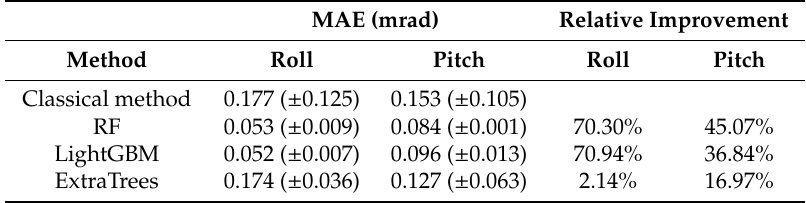
Table 8. Narrow range experiment results for predication of a new orientation after 1 s. MAE (mrad)